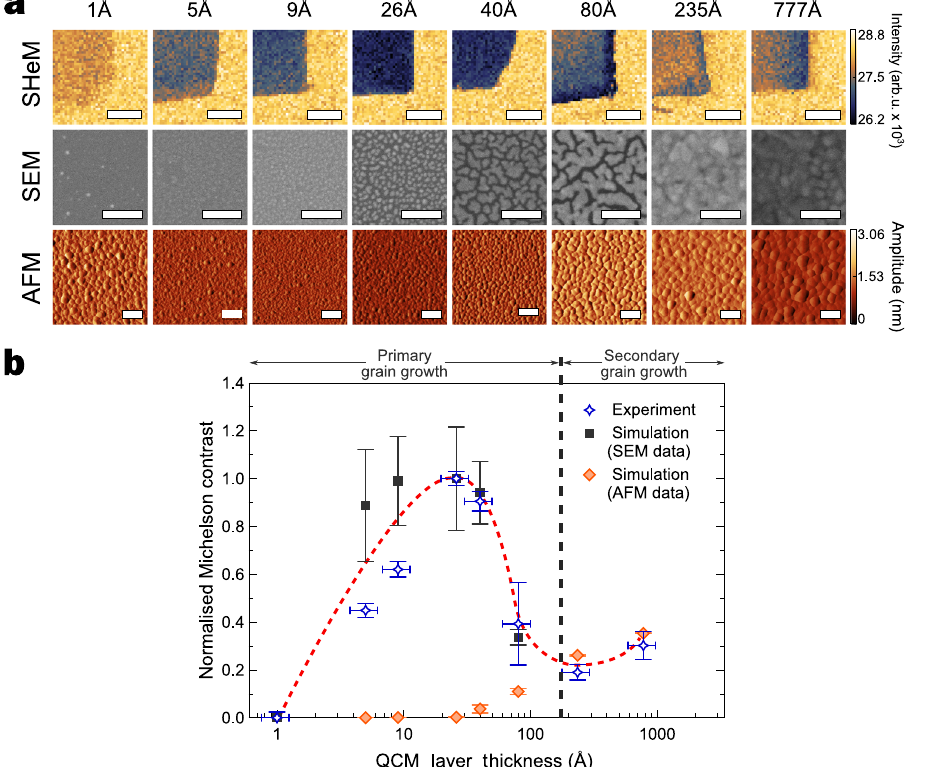
Fig. 3 | Experimental and modelled SHeM contrast for thermally evaporated gold layers on silicon. a AFM (amplitude), SEM and SHeM micrographs of the manufacturedgold-on-siliconsamples,withthequartzcrystalmicrobalance(QCM) thickness of the evaporated gold indicated along the top. AFM and SEM images show speci fi cally the gold region of the sample in order to illustrate the develop- ment of surface features according to the growth mode of the material. Such features form the basis for the masking and shadowing responsible for the observedSHeMcontrast.SHeMmicrographsshowagold-siliconinterface,withthe gold being the darker material. Scale bars for the AFM and SEM micrographs are 100nm in length; SHeM scale bars 400 µ m in length. All AFM images have been restricted to the same amplitude range (derived from the maximum amplitude found across the total dataset, namely 0 – 3.06nm) for direct comparison. SHeM